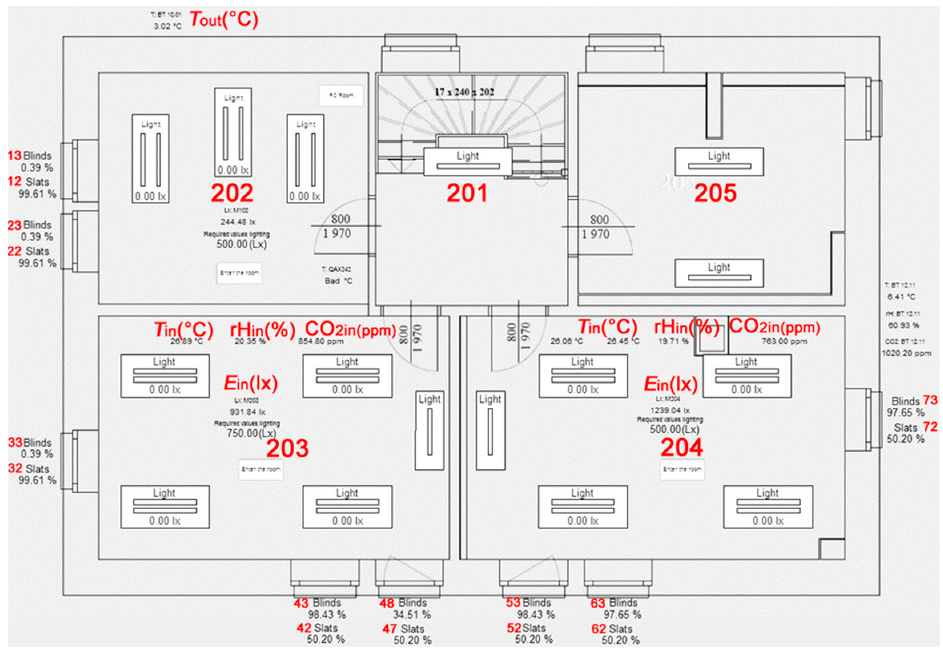
Figure 2. The main visualization screen in SW tool PI ProcessBook, first floor.